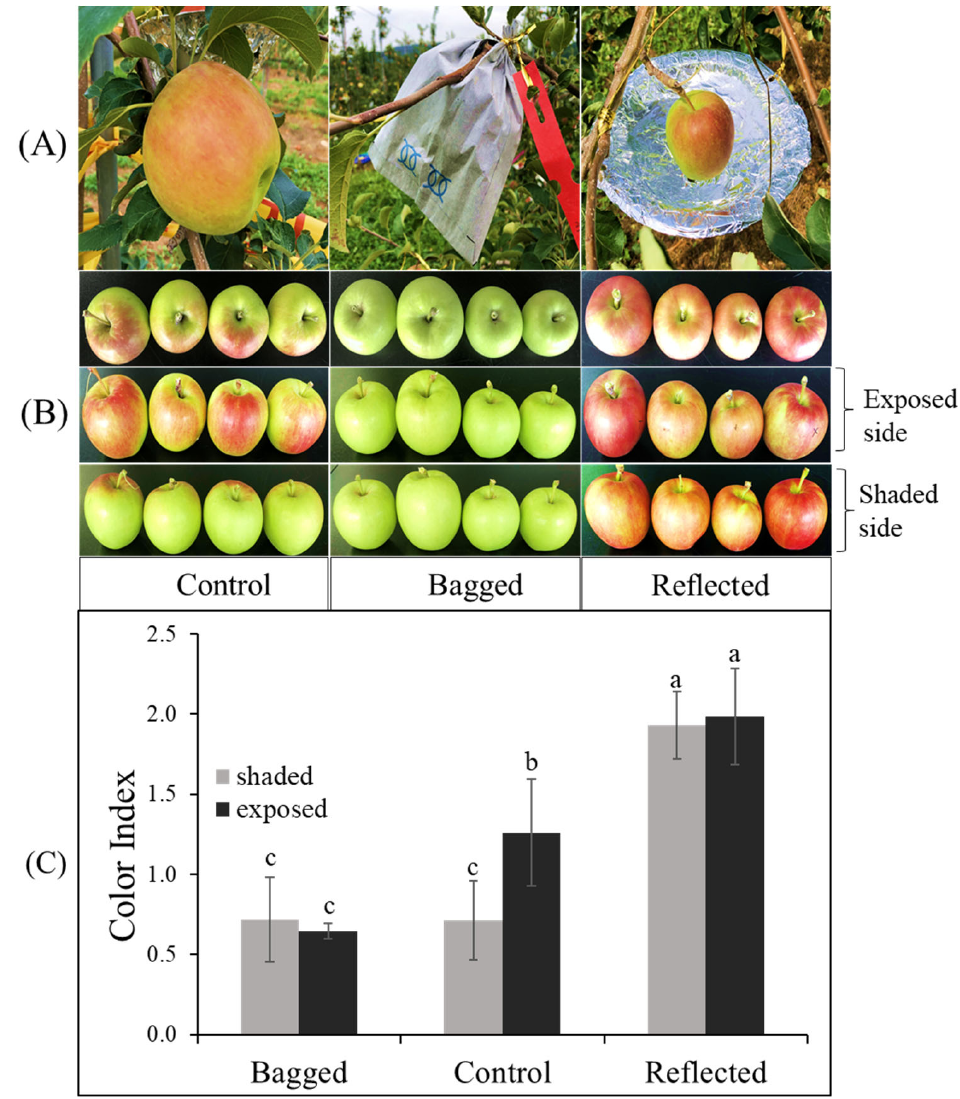
Figure 2. Effect of sunlight treatment on the differential coloration of orchard-based apple fruit ‘Summer Prince’ ( A ). The fruits showed different coloration patterns between the three groups: reflected sunlight, bagged, and control ( B ) which is indicated in the color index ( C ) after seven days of treatment. Different letters above the bars indicate a significant difference ( p < 0.05). Data are presented as mean ± SD ( n = 20) of three biological replicates.